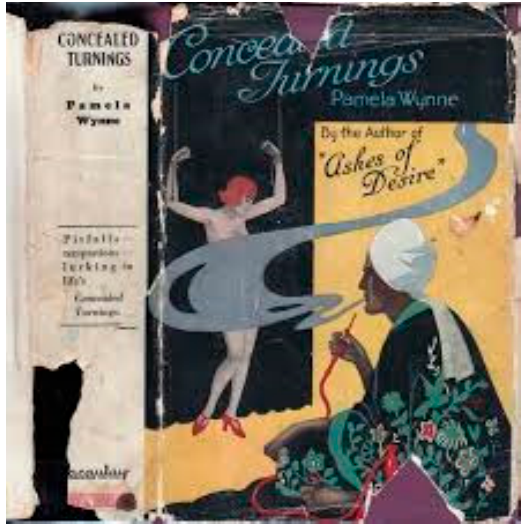
Figure 7. Concealed Turnings by Pamela Wynne 1927.